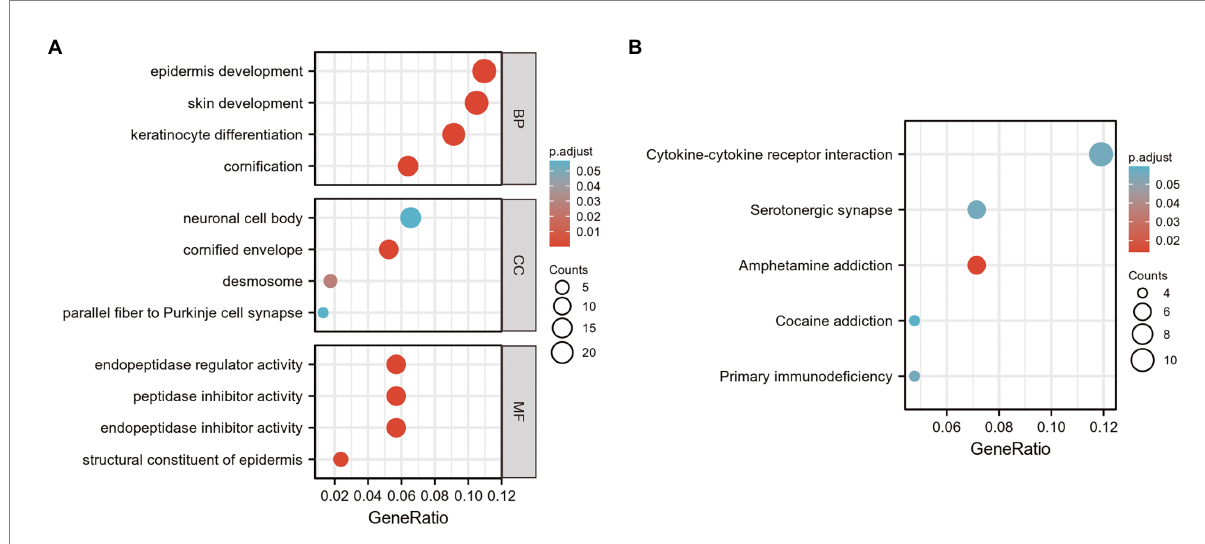
FIGURE 3 GO and KEGG analysis of DEGs in GSE23586 and GSE7621 datasets. (A) GO function enrichment analysis of DEGs in GSE23586 and GSE7621 dataset. GO, Gene Ontology; MF, Molecular Function; BP, Biological Process; CC, Cellular Components; DEGs, differentially expressed genes. (B) Enrichment analysis of the KEGG signaling pathway of DEGs in GSE23586 and GSE7621